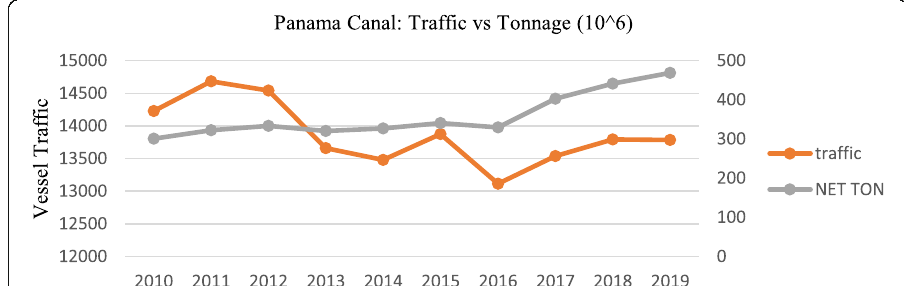
Fig. 1 Panama Canal Traffic and Traffic vs. Net Tonnage comparison for period 2010 – 2018. Source: Panama Canal Authority